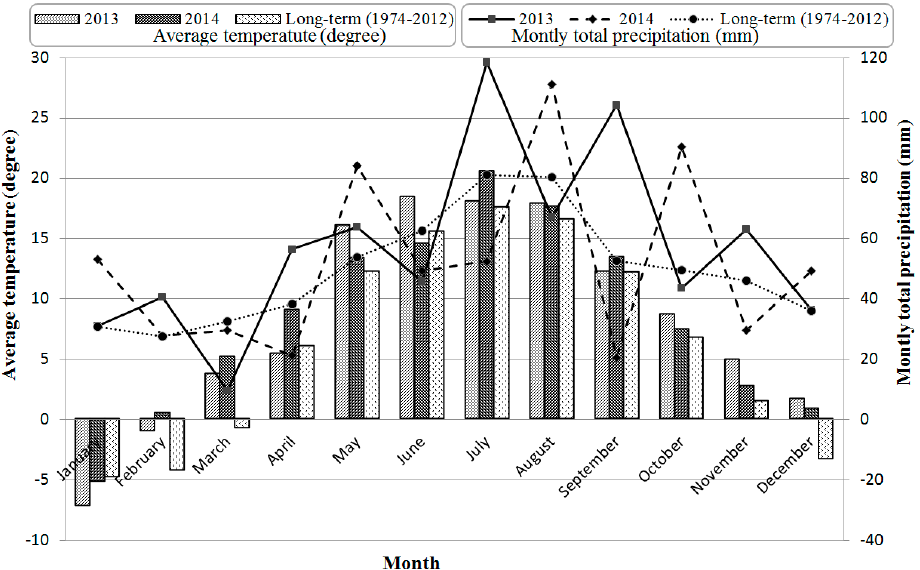
Figure 1. Meteorological characteristics.